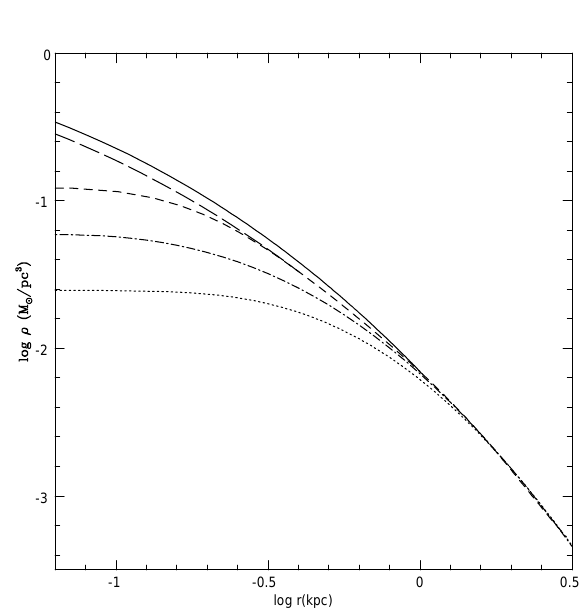
Fig. 1. Density profile evolution of a 10 9 M ⊙ halo with baryon fraction f d ≃ 0 : 04 and a specific angular momentum h ≃ 400 kpc km s − 1 ( (cid:21) ≃ 0 : 05), starting from z = 10 (solid line), when the profile is a NFW profile. The following evolution represented by the long-dashed line, short-dashed line, dot-dashed line, dotted line represents the profile at z = 3 ; 2 ; 1 ; 0,